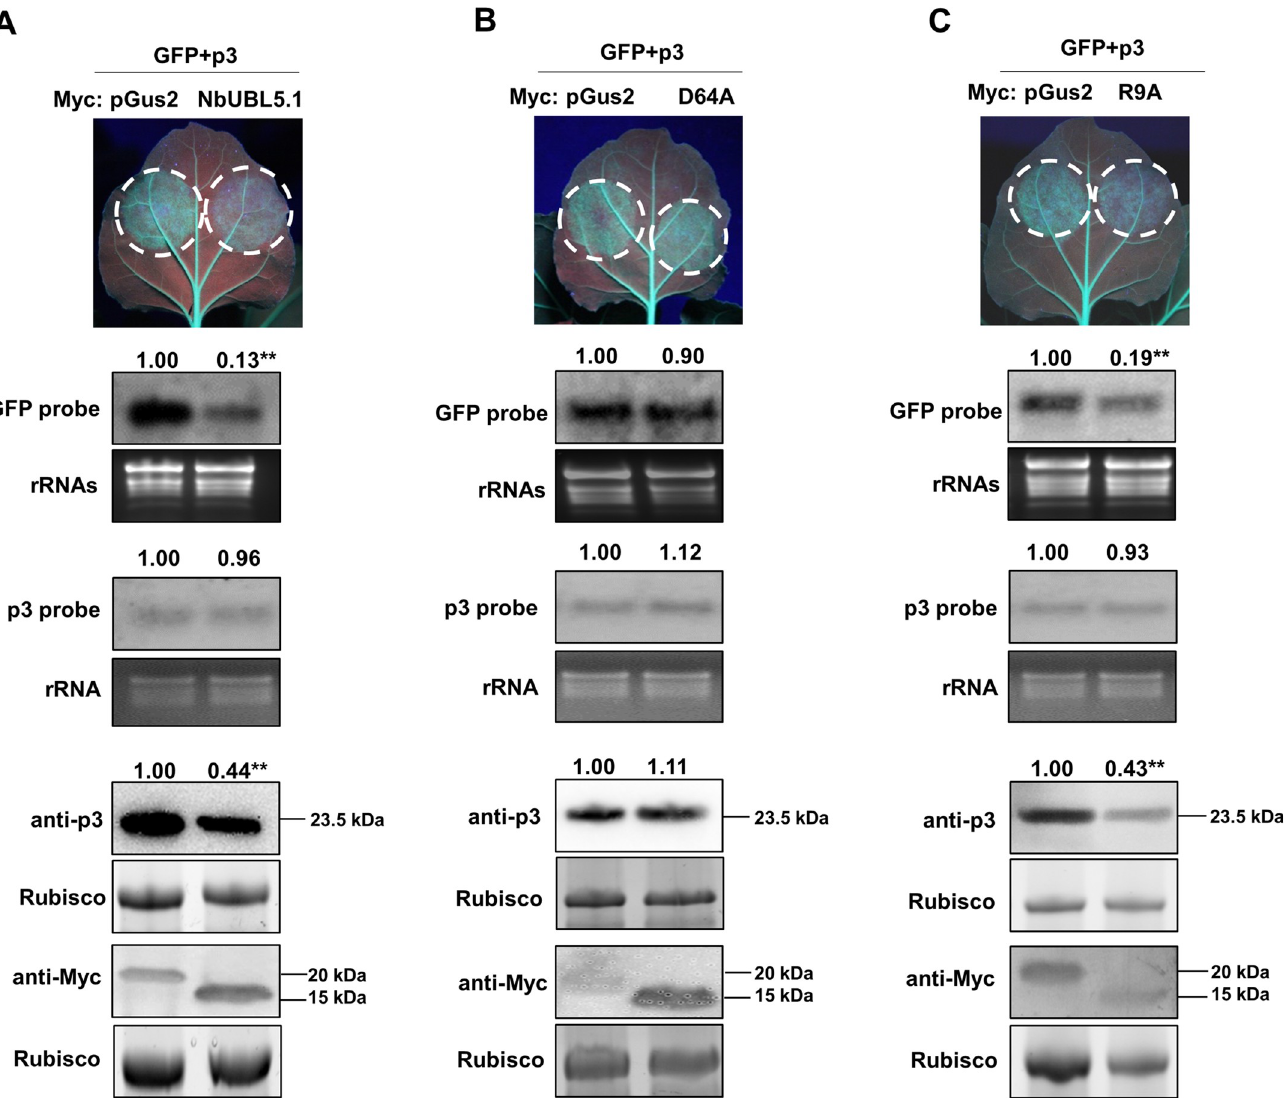
Fig 3. Transient expression of NbUBL5.1 impairs the function of p3 as a suppressor of RNA silencing. A. Myc-fused NbUBL5.1 or control protein pGus2 (The N-terminal peptide of GUS with 122 amino acids) was co-expressed with GFP and p3 in 16c leaves. At 5 dpi, there was strong fluorescence in zones expressing GFP, p3 and pGus2-Myc, while the fluorescence in zones expressing GFP, p3 and NbUBL5.1-Myc was significantly weaker. GFP mRNA accumulated less when NbUBL5.1-Myc was expressed. Western blot demonstrated the expression of Myc-fused pGus2 or NbUBL5.1, while showing that p3 accumulated less in zones expressing Myc-NbUBL5.1, p3 and GFP. B and C. Effect of NbUBL5.1 mutants (D64A and R9A) on p3. Mutant D64A (B) had no effect on p3 accumulation and its function as a silencing suppressor, while mutant R9A (C) retained the effect on p3. Results are from three biological replicates. Band intensity in blots was calculated by ImageJ based on three replicates. A two-sample unequal variance directional t test was used to test the significance of the difference ( �� , p value < 0.01).